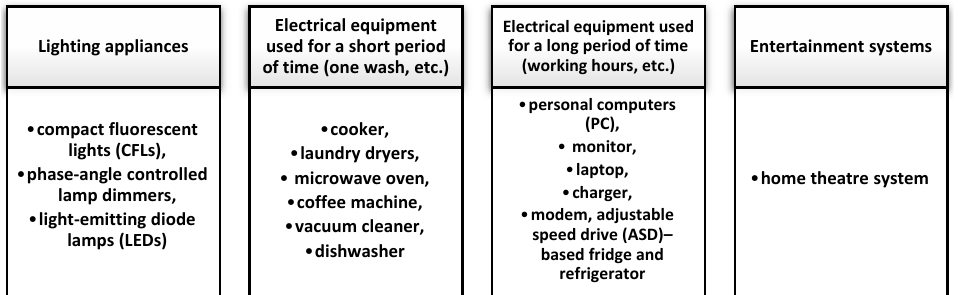
Figure 1. Groups of modern power electronic-driven appliances.